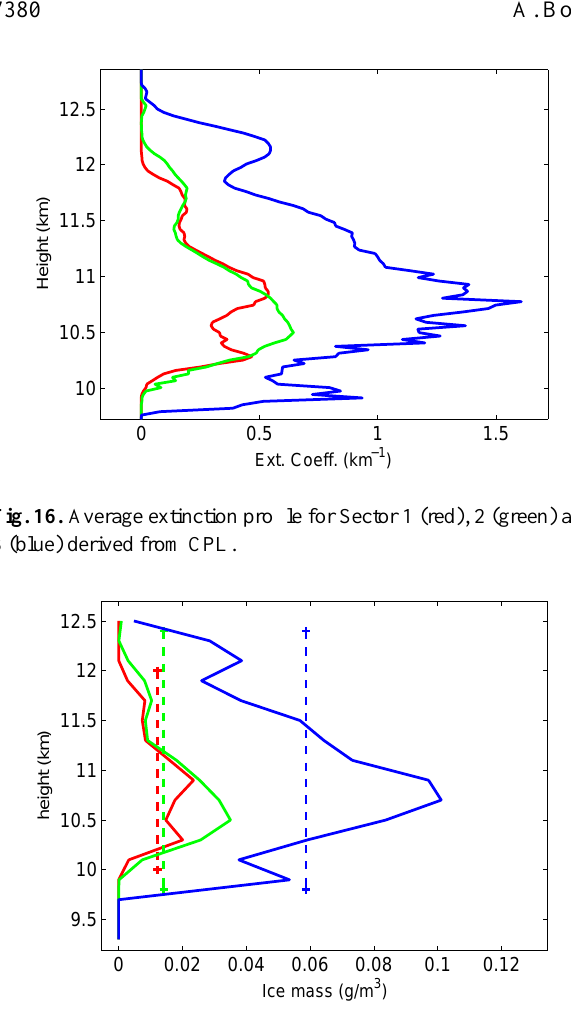
Fig. 17. Average IWC profile, for the LBLMS layering, for Sector 1 (red), 2 (green) and 3 (blue) derived as explained in the text. The vertical dashed lines indicate the profiles adopted for the homoge- neous computations.